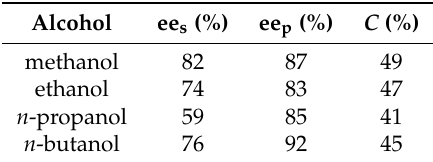
Table 4. E ff ect of alcohol on the parameters of kinetic resolution of ( R , S )-flurbiprofen. CALB immobilized onto IB-150A after 20 h (in DCE) of incubation. Alcohol ee s